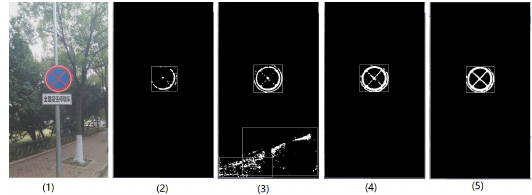
Figure 18: Results Obtained By Different Color Space In Strong